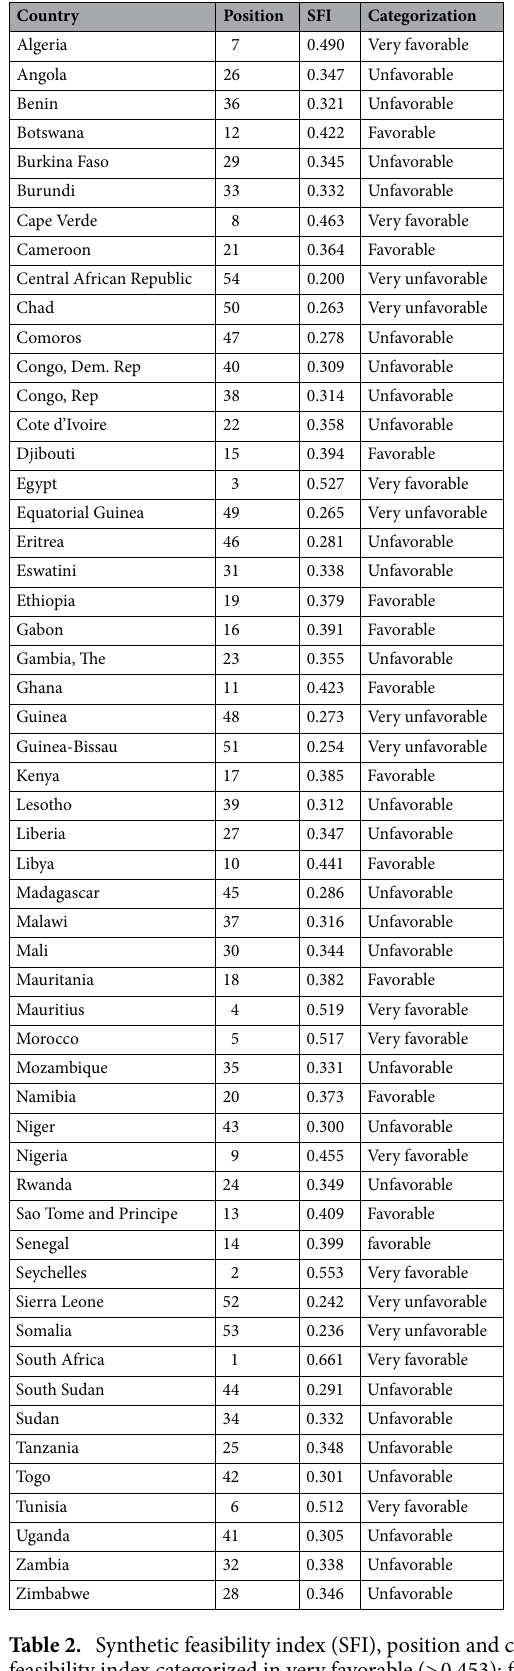
Table 2. Synthetic feasibility index (SFI), position and categorization for each African Country. Synthetic feasibility index categorized in very favorable (> 0.453); favorable (0.453–0.363); unfavorable (0.363–0.273); very unfavorable (<